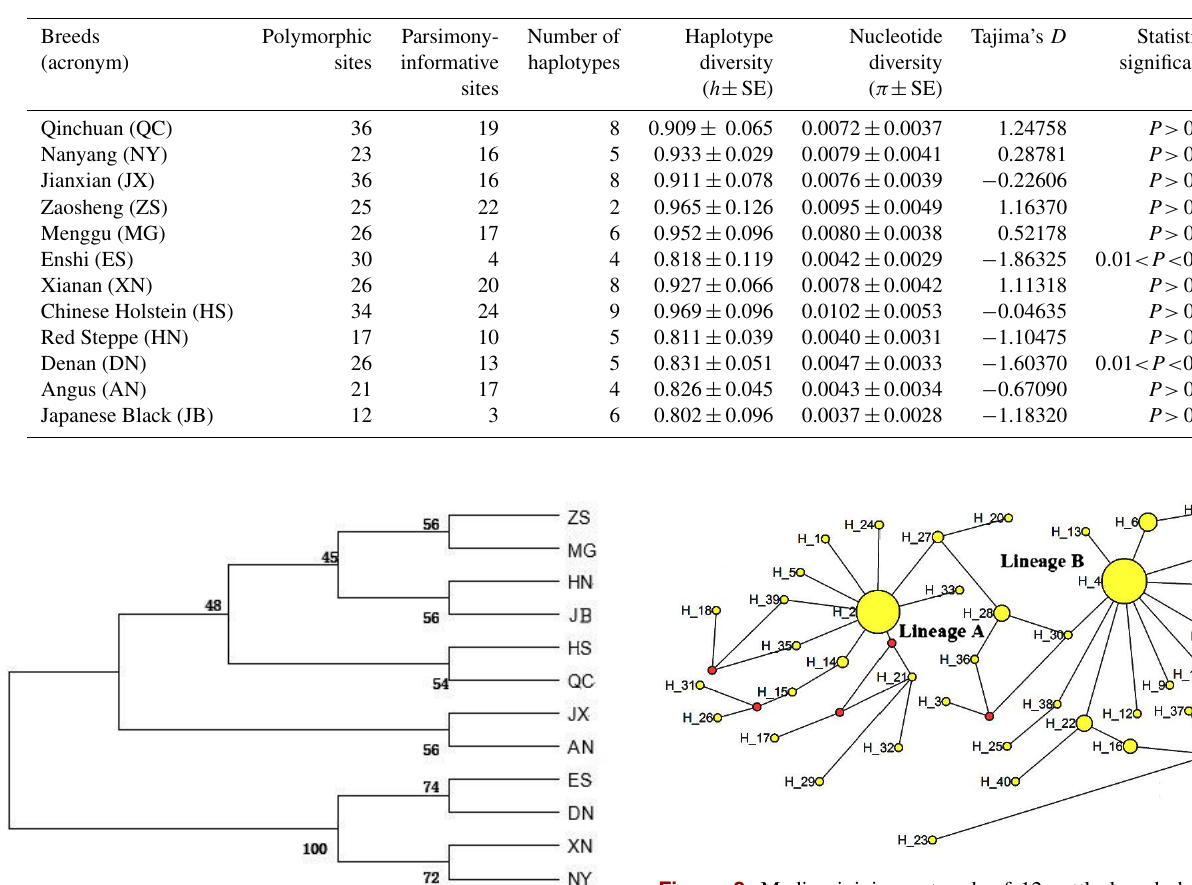
Figure 2. Median-joining network of 12 cattle breeds based on mtDNA 16s rRNA gene sequences (circle areas proportional to sample